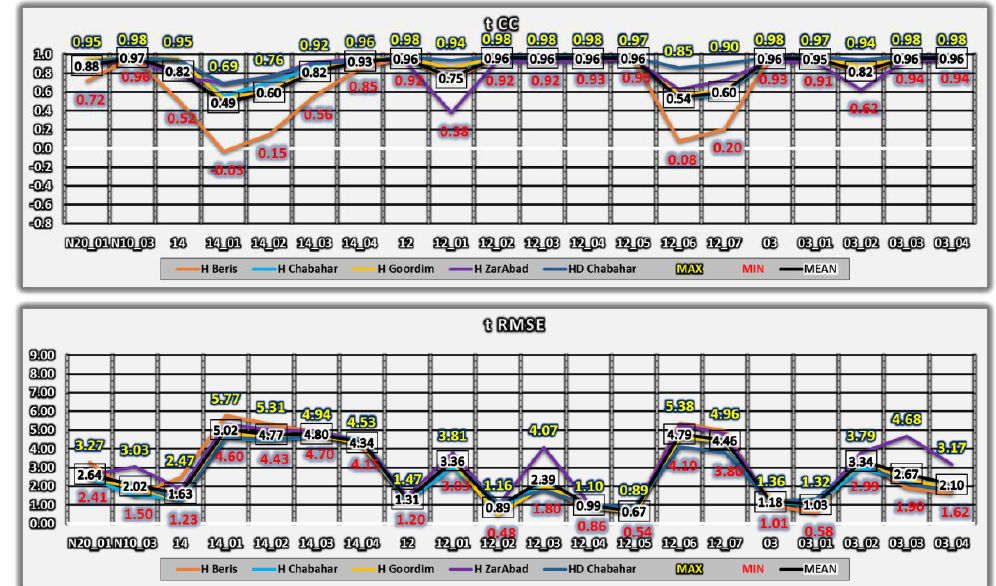
Figure 9. Correlation coefficient and RMSE of surface temperature for model results and HYCOM